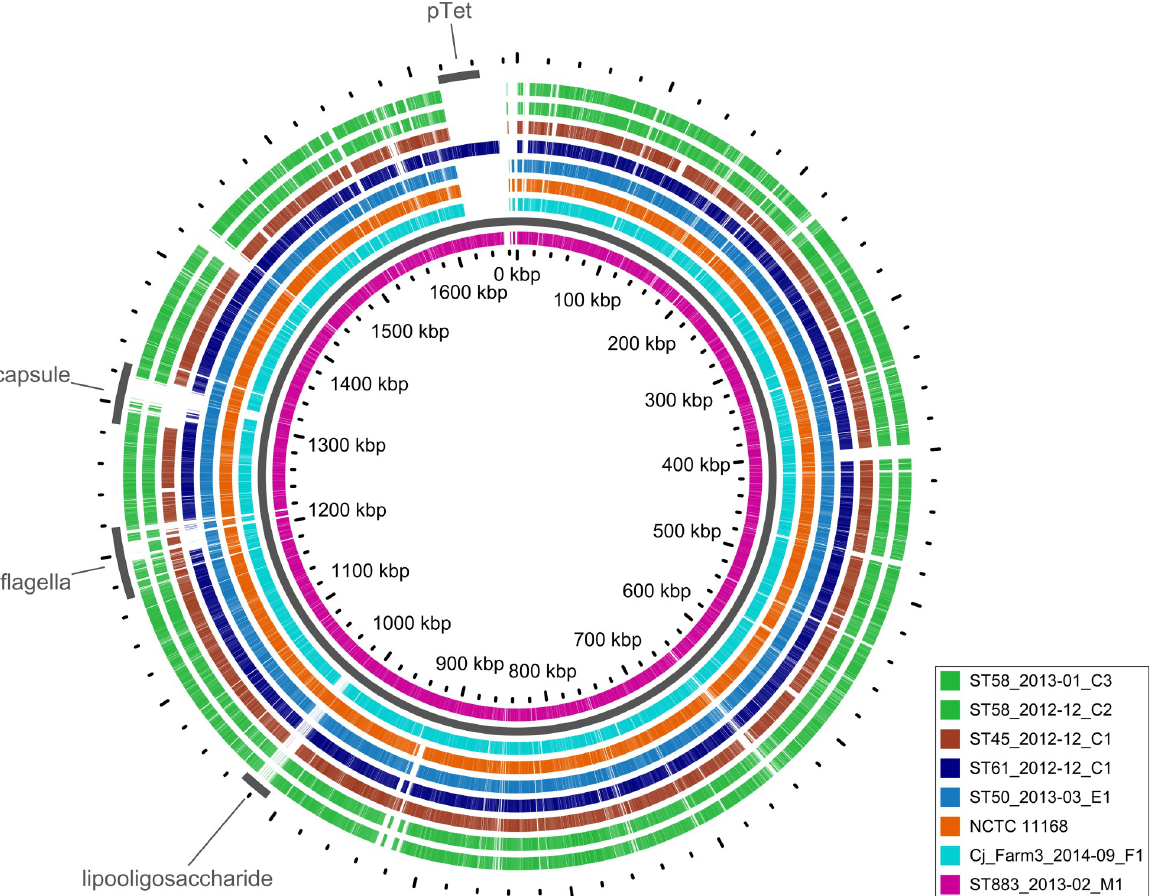
Fig 6. BLAST atlas of the representative farm strains and NCTC 11168 against the outbreak strain (ST883_2013–02_M1).